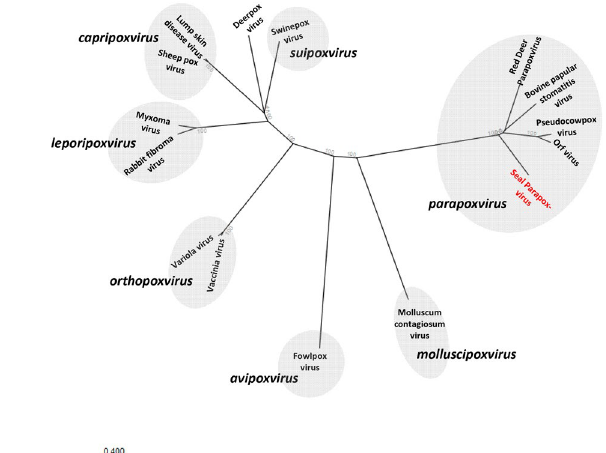
Figure 3. Phylogenetic tree analysis based on 47 proteins. Protein sequences were considered being conserved, if the corresponding sequence of SePPV yielded BLASTP alignments over at least 90% of the SePPV protein sequence length with sequences of all 14 representative genomes. The following sequences were used: Red Deer Parapoxvirus (PVNZ) HL953 (NC_025963.1); ORFV (AY386264.1); PCPV (NC_013804.1); BPSV (NC_005337.1); Vaccinia Virus (NC_006998.1); Variola Virus (NC_001611.1); Myxoma Virus (NC_001132.2); swinepox virus (NC_003389.1); deerpox virus (NC_006966.1); sheep pox virus (NC_004002.1); lumpy skin disease virus (NC_003027.1); fowlpox virus (NC_002188.1); rabbit fibroma virus (NC_001266.1); molluscum contagiosum virus